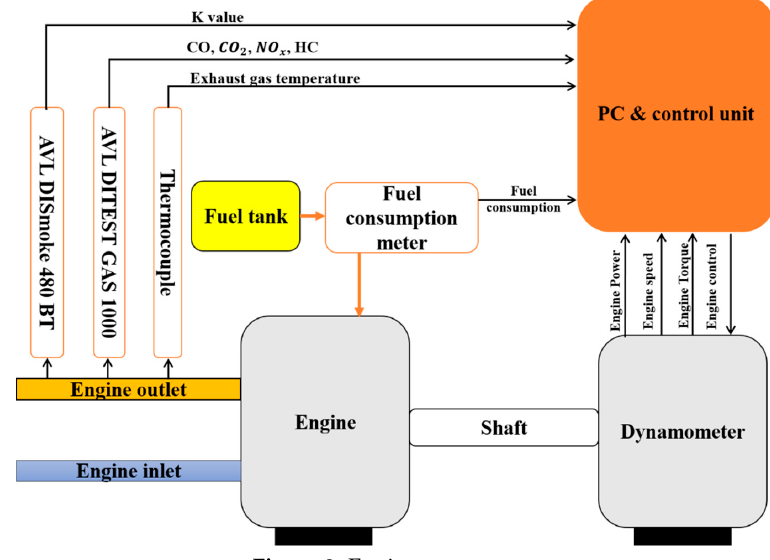
Figure 2. Engine test set up. Table 2. Engine characteristics.